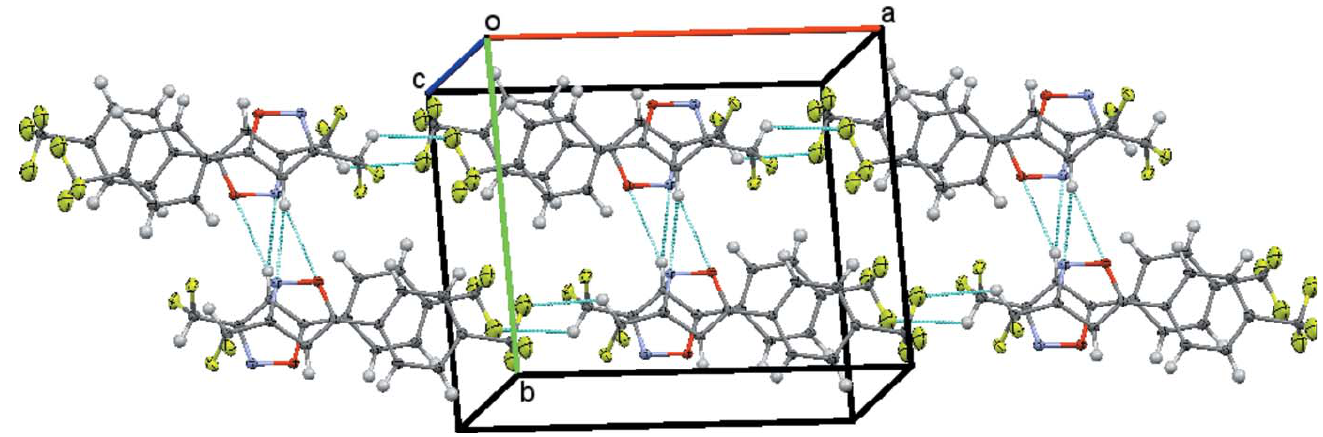
Figure 2 Overall packing of the title compound viewed along the c -axis direction. Hydrogen bonds are drawn as dashed lines.